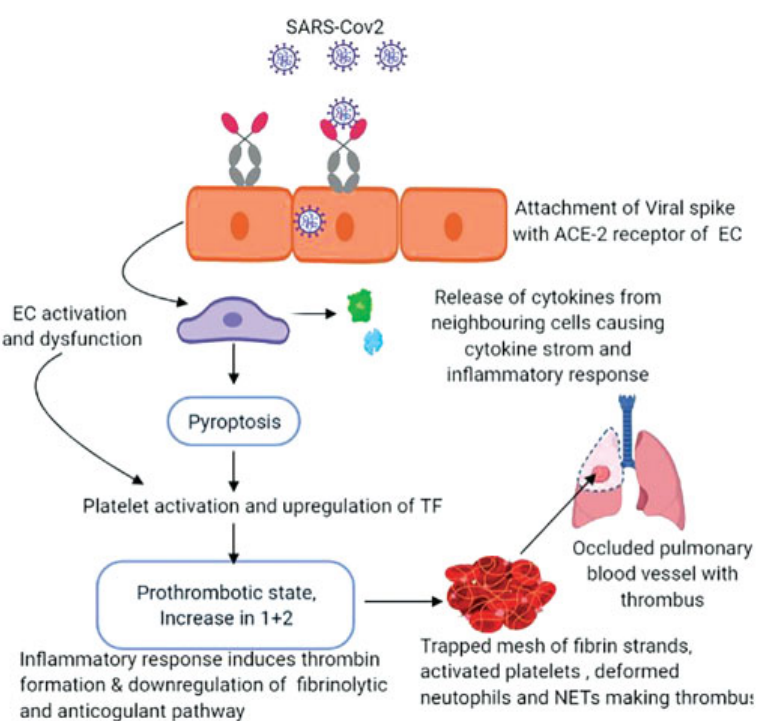
Fig. 3 Mechanism of CIC induced Thrombosis: The viral particles enter the host through ACE-2 receptors found on endothelial cells (EC) of respiratory pathway resulting in endothelial activation and dysfunction that leads to pyroptosis and cytokine storm. This in turn causes platelet activation and upregulation of tissue factor (TF) and fragment (1 þ 2). The spiked in fl ammatory response along with downregulation of anticoagulant and fi brinolytic pathway leads to formation of